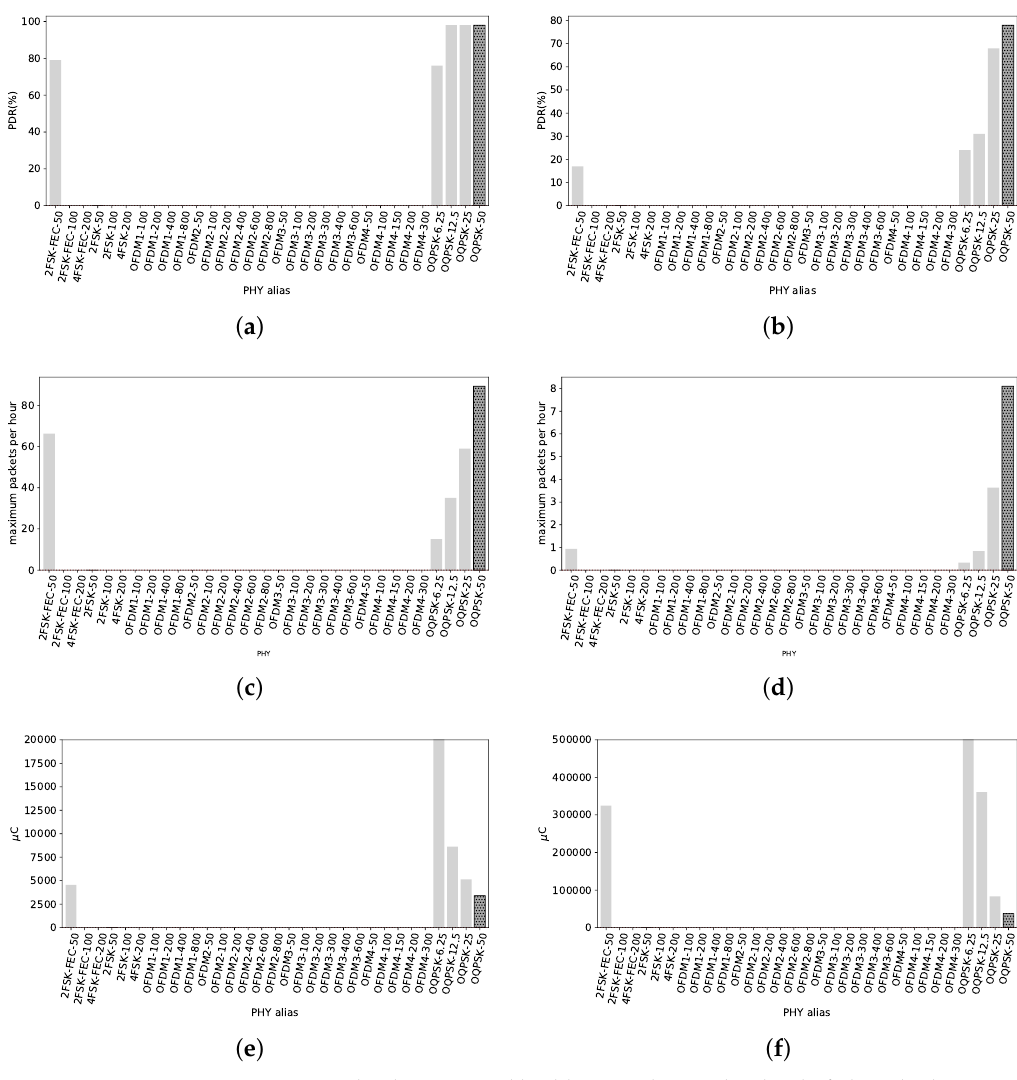
Figure 14. AMI, 400 m. It is normal to have several buildings and any other kind of obstacles between nodes. Having these conditions, the most useful radio setting is OQPSK-50. ( a ) PDR values with packets of 127 B. OQPSK-12.5, OQPSK-25 and OQPSK-50 have 98% PDR. We see that the most advantageous of that group is OQPSK-50, offering same reliability with higher data rate; ( b ) PDR values with packets of 2047 B. OQPSK-50 offers the highest reliability, 78%, between the 5 radio settings with non-zero PDR; ( c ) Maximum amount of TX short packets under 0.1% duty cycle regulation. O-QPSK-50 can send up to 90 short packets, more than any other radio setting; ( d ) Maximum amount of TX long packets under 0.1% duty cycle regulation. OQPSK-50 is able to send up to 8 long packets within one hour; ( e ) Average electric charge consumed per packet of 127 B transmitted. OQPSK-50 consumes on average, 3.4 mC per packet transmitted; ( f ) Average electric charge consumed per packet of 2047 B transmitted. OQPSK-50 is the less electric charge-hungry radio setting, consuming 37 mC per packet